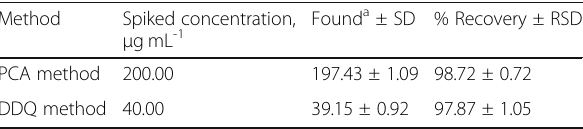
Table 7 Results of percent recovery of MFH in the analysis